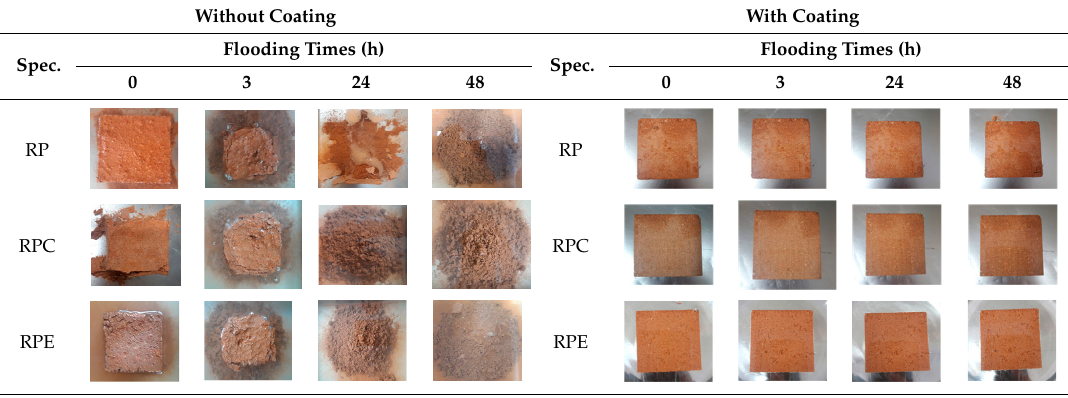
Table 5. Water Loosening Results for Red Clay Binder Specimens. With Coating